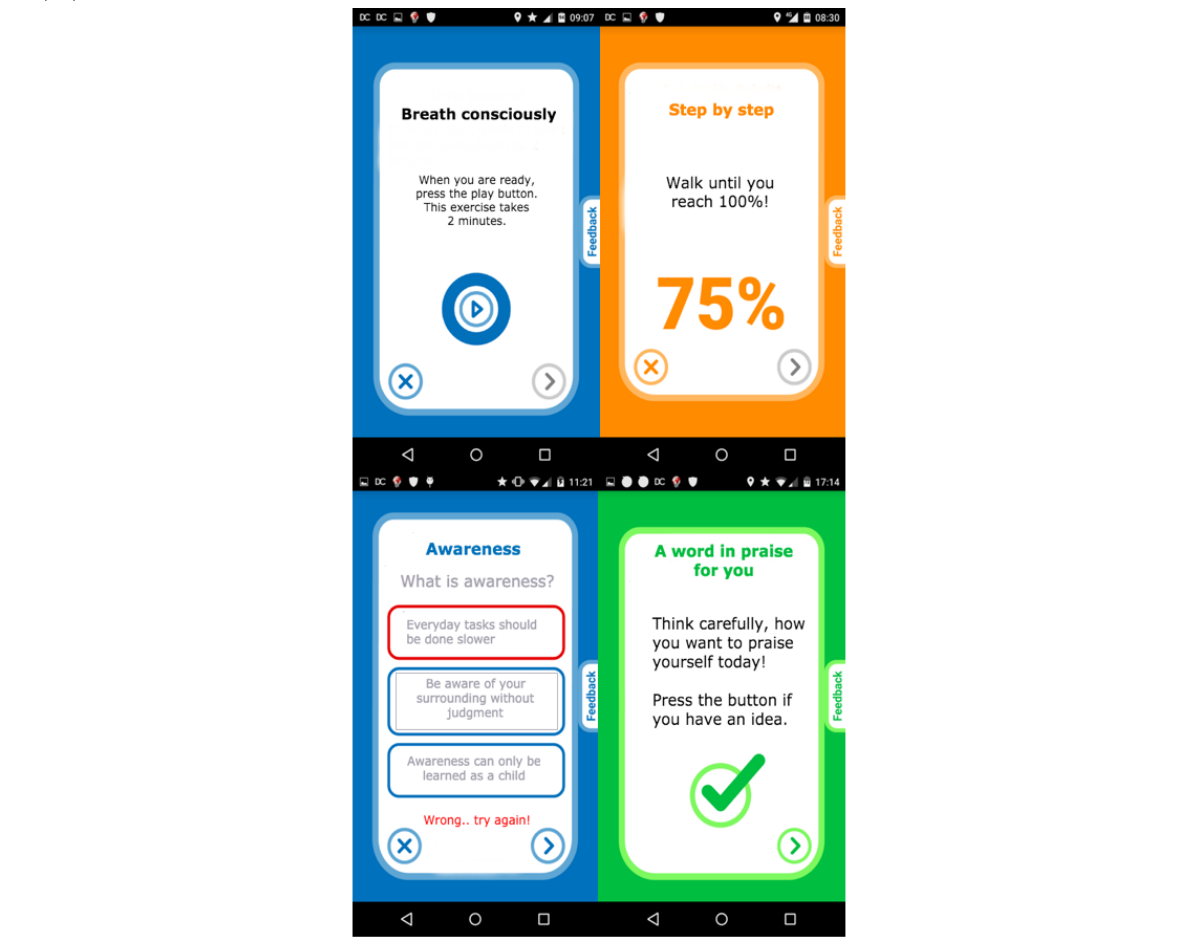
Figure 6. Sample screenshots of intervention types (see Table 2) #6, #1, #2, and #3 (clockwise). Note: The screenshots were translated from German for demo